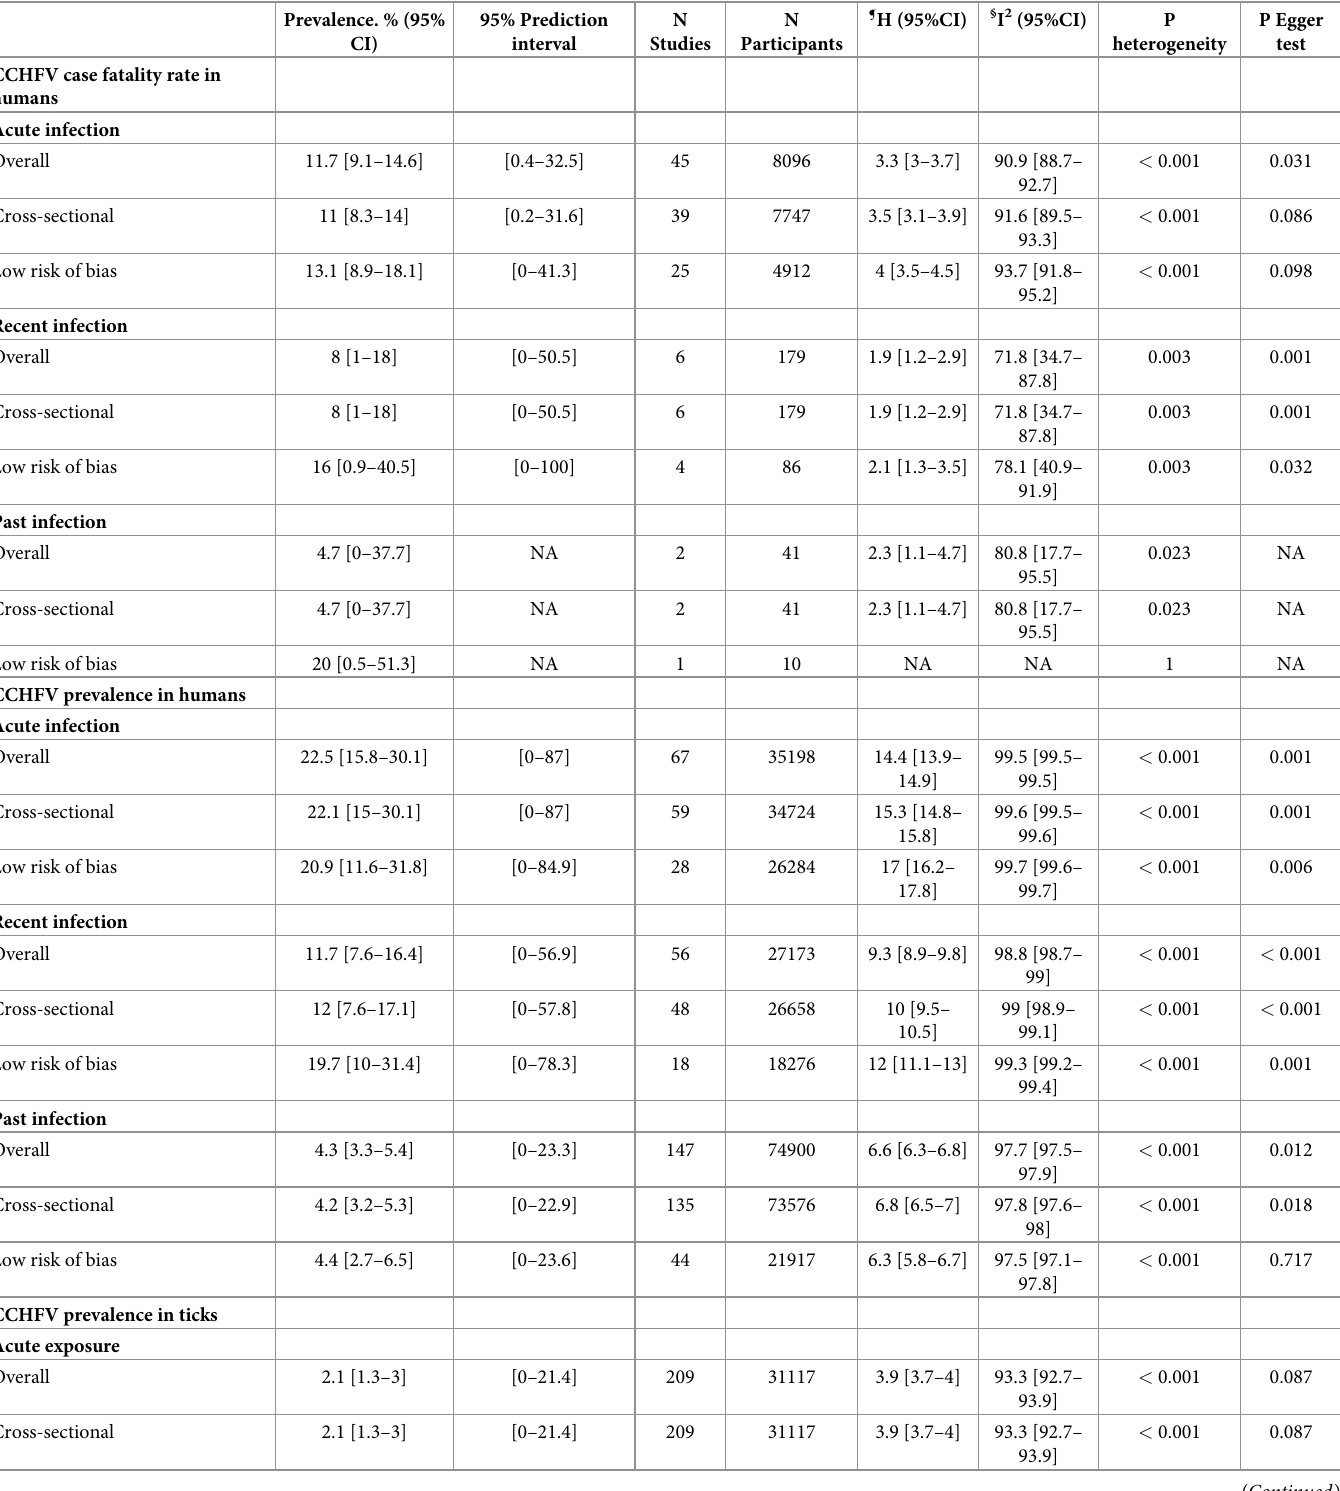
Table 1. Summary of meta-analysis results for global prevalence of Crimean-Congo Hemorrhagic Fever Virus in humans, ticks, and other animal